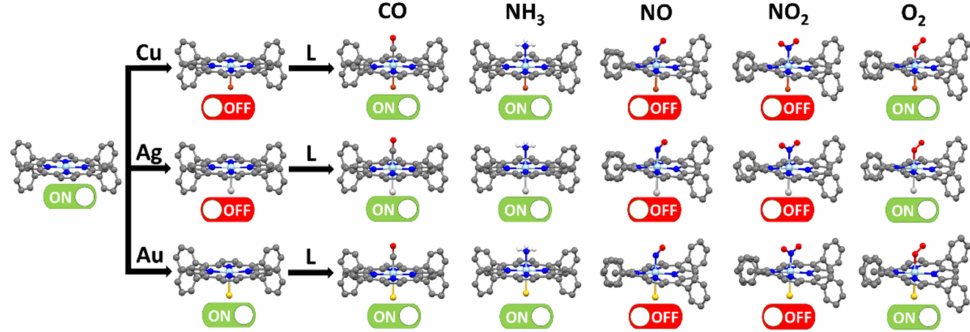
Figure 3. Schematic representation of the magnetic behavior (“switch on”/“switch off”) of the free CoTPP (first column), MS-supported CoTPP (MS = Cu, Ag, and Au; second column,) and MS-supported CoTPP interacting with L (L = CO, NH 3 , NO 2 , NO, and O 2 ; third—seventh